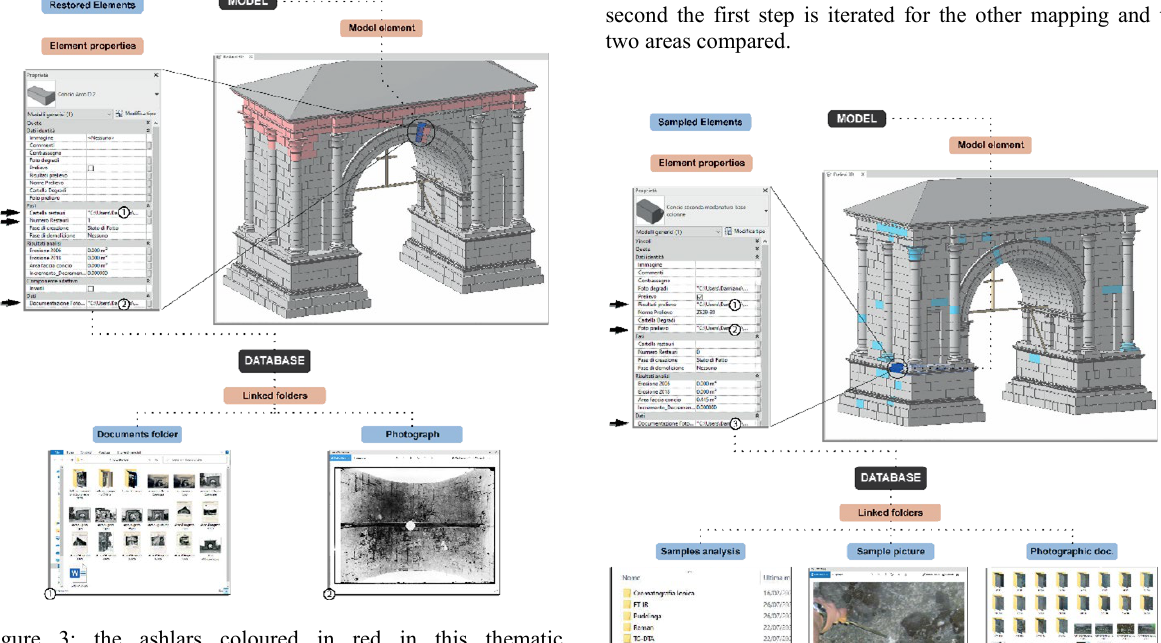
Figure 3: the ashlars coloured in red in this thematic representation have been interested by previous restoration interventions. They are linked to archival data (reports, photos) which allow the user to have specific details.